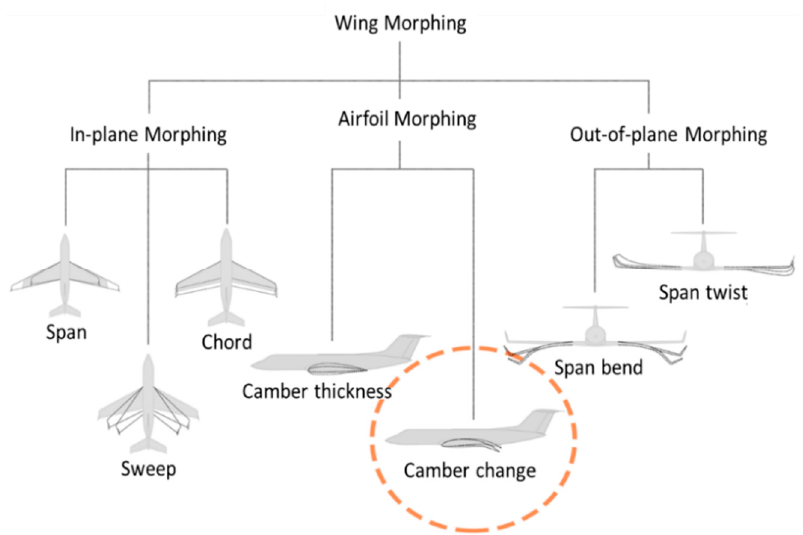
Figure 1. Diagram of categories of wing morphing, with camber change morphing highlighted.